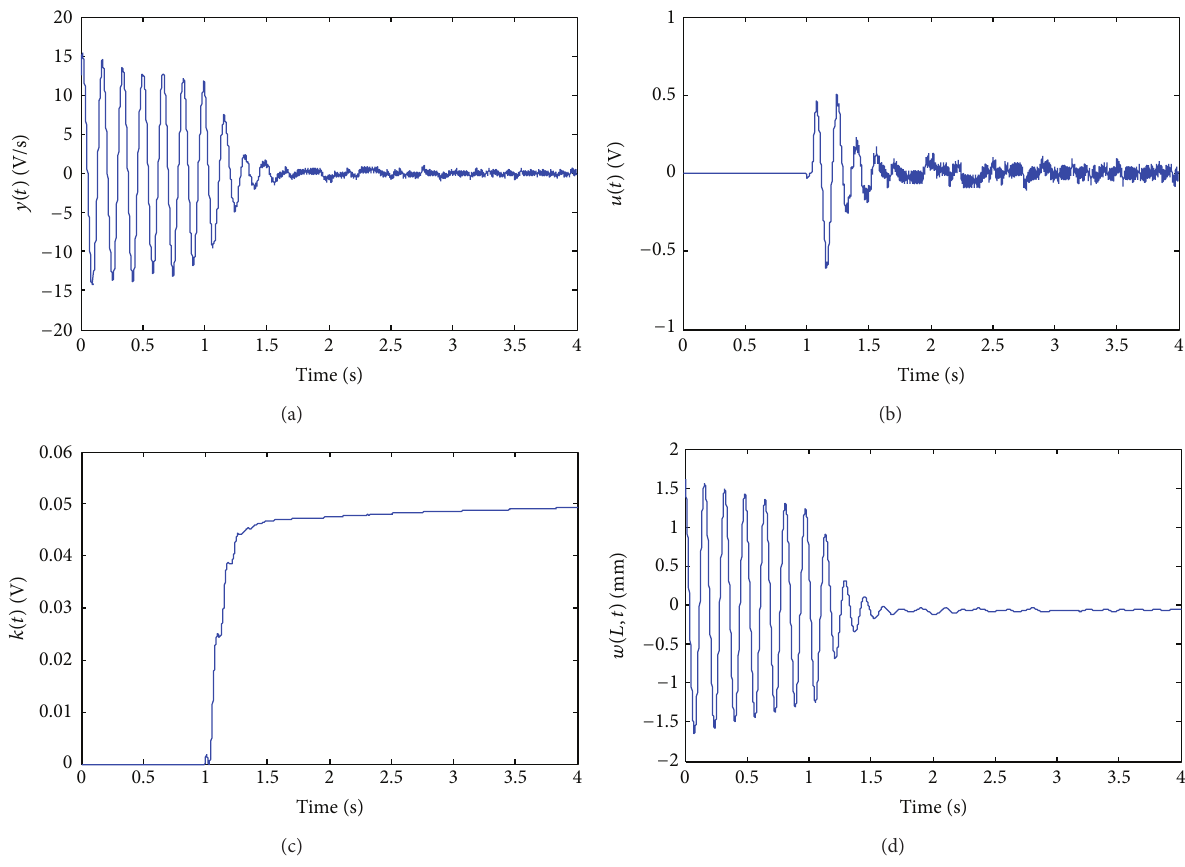
Figure 8: Experimental result (the controller was activated at 𝑡 = 1 sec): (a) feedback signal, (b) control signal, (c) adaptive variable, and (d) tip